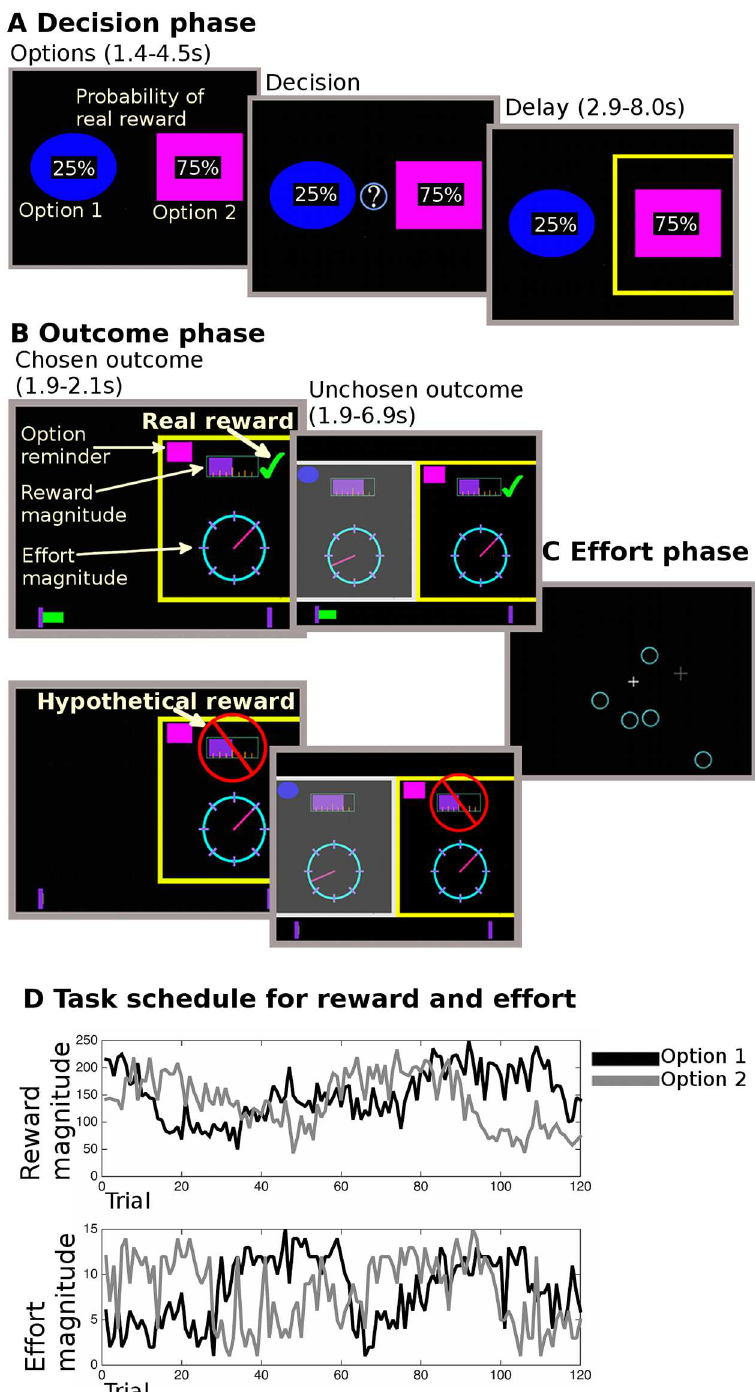
Fig 1. Task description. In the decisionphase(A), participantswere shown two options (i.e., choices) overlaidwith a cue (percentagenumber) informing them of the probabilityof receivinga real (rather than hypothetical) reward for each choice. They could only decideafter an initial monitoringphase(1.4–4.5 s). The chosen option was then highlightedfor 2.9–8s. In the followingoutcome phase (B), participantssaw the outcome for the chosen optionfirst (1.9–2.1 s). The reward magnitude was shown as a purplebar (top of the screen); the effort magnitude was indicatedthrough the positionof a dial on a circle. Whether they receiveda reward(i.e., the trial’s reward type) was indicatedby a green tick mark (real reward, top display)or a